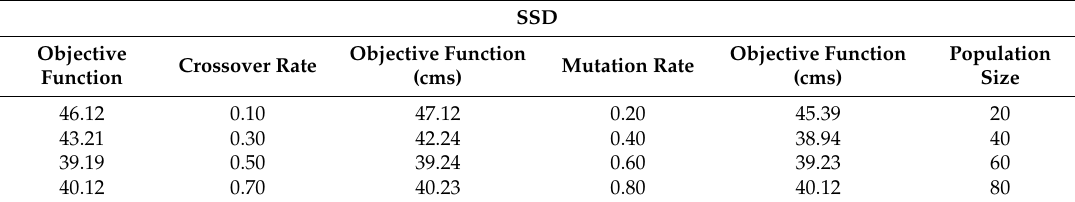
Table 2. Analysis for the performance of the Genetic Algorithm (GA) (Wilson flood).